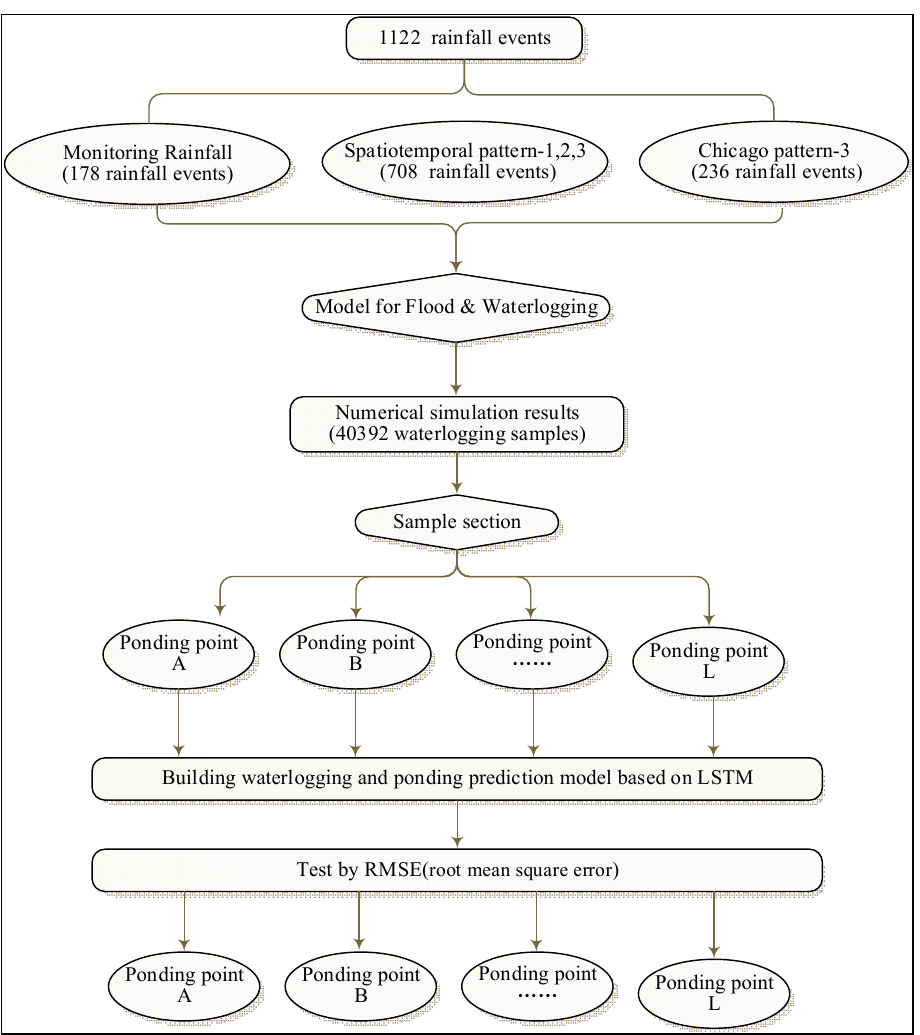
Figure 3. Chicago rainfall pattern.